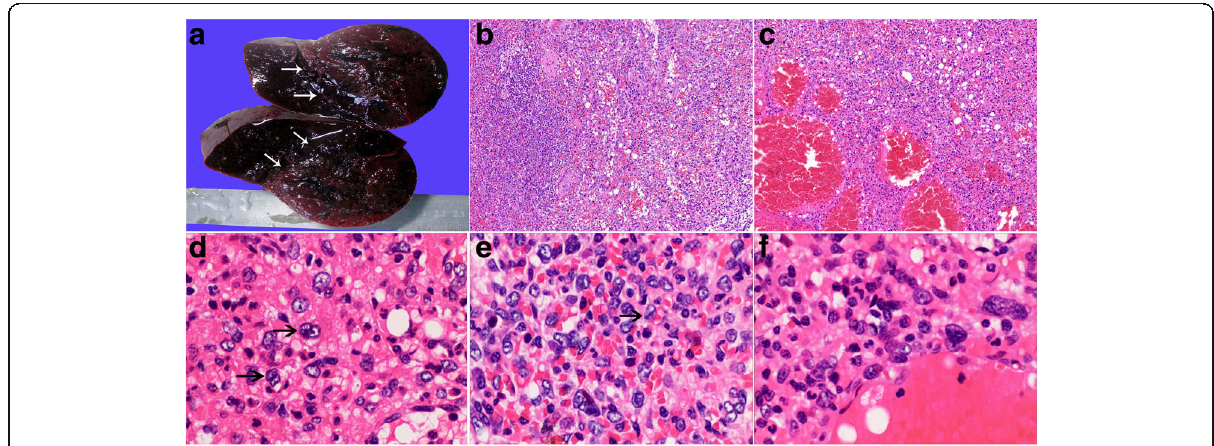
Fig. 2 a The cut surface of the resected spleen, illustrating a solitary, round and dark-red mass with expansile growth compressing the surrounding parenchyma (10% buffered formalin-fixed). b Low-power view showing the lesion (right field) composed of unorganized sinusoid-like channels without malpighian corpuscles, less well demarcated from the adjacent normal splenic tissue (left field) (H&E, ×100). c In some areas, the cavernous vascular channels were filled with erythrocytes and foci of fat vacuoles can be noted (H&E, ×100). d-f Many bizarre large cells are scattered in the stroma throughout the lesion, with oval, reniform, multilobulated, or convoluted nuclei. The chromatin is pale, granular or vesicular. Sometimes nuclear grooves (e, arrow) are present. Note large cells (d, arrows) with double nuclei and apparent eosinophilic nucleoli mimicking Reed-Sternberg cells in classical Hodgkin ’ s lymphoma. (H&E,